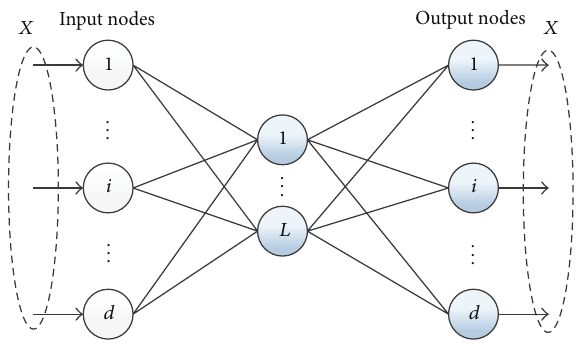
Figure 1: ELM-AE